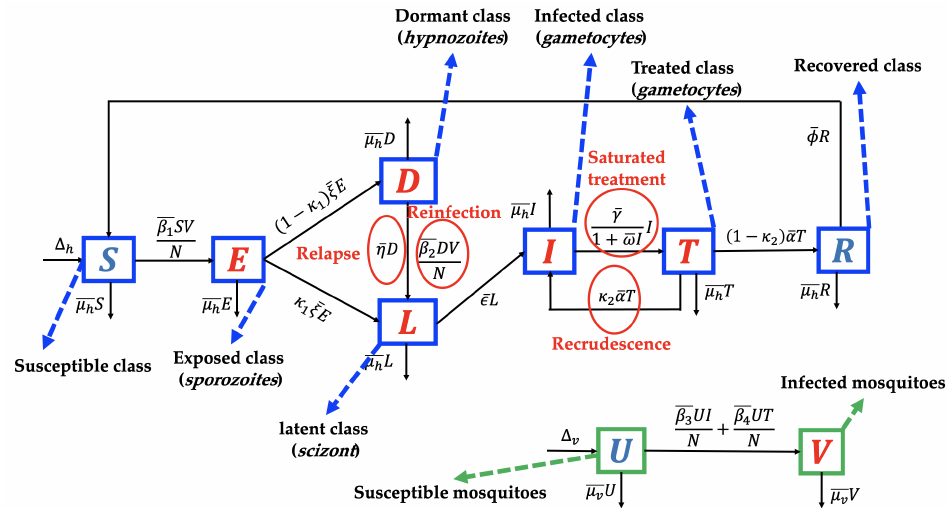
Figure 1. Transmission diagram of malaria disease considering relapse, reinfection, recrudescence, and saturated